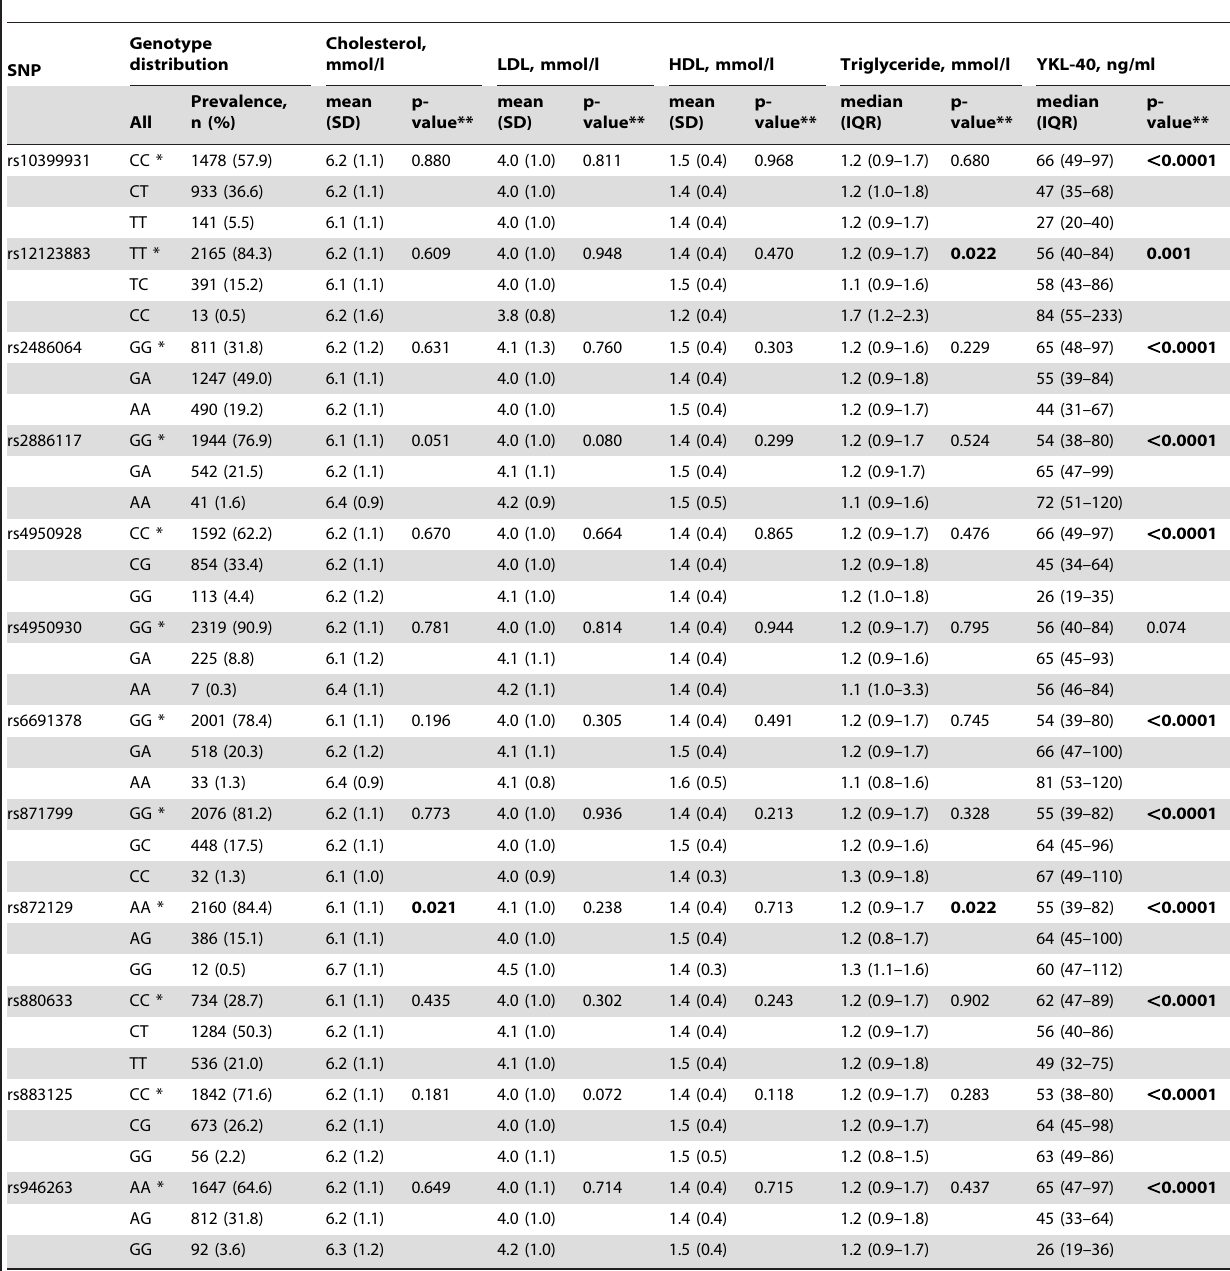
Table 2. The relationship between 12 single nucleotide polymorphisms (SNPs) of CHI3L1 and levels of lipid parameters and YKL-40 in